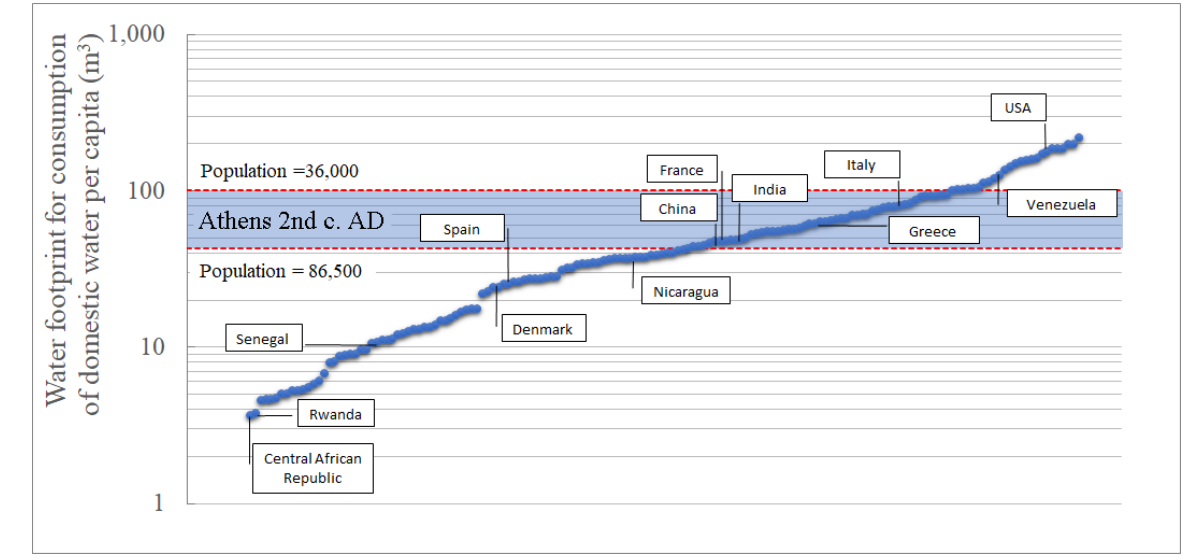
Figure 30. Footprint of the annual consumption of domestic water per capita (1996–2005) [22,23].